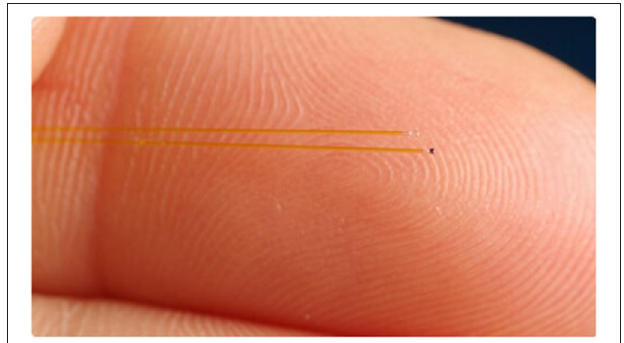
FIGURE 1 | Fiber optic pressure sensor 200 µ m (Courtesy of FISO).